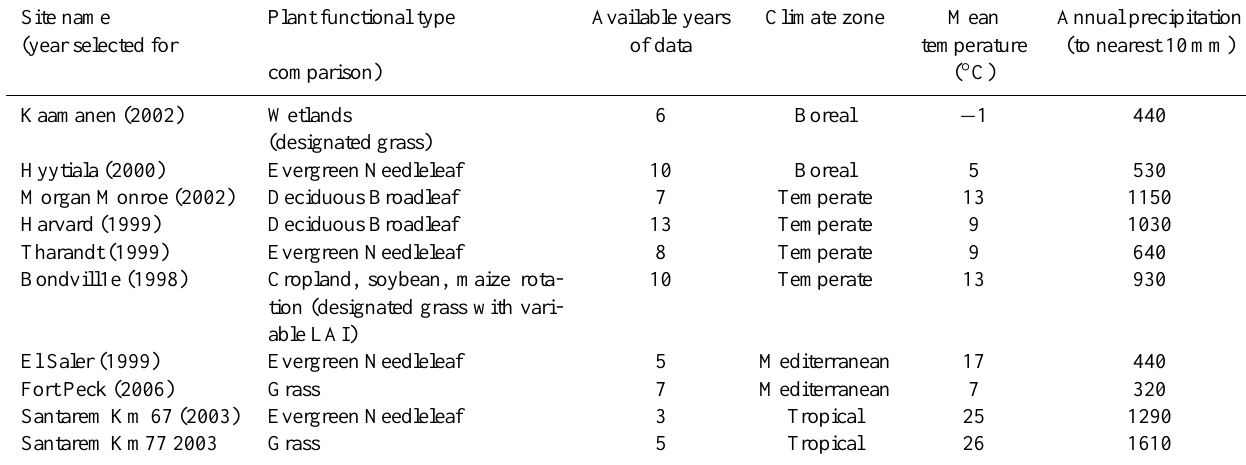
Table 1. Summary climate and site descriptions of F:LUXNET